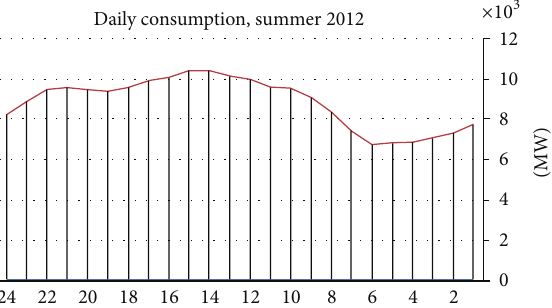
Figure 3: Hourly consumption, summer 2012.